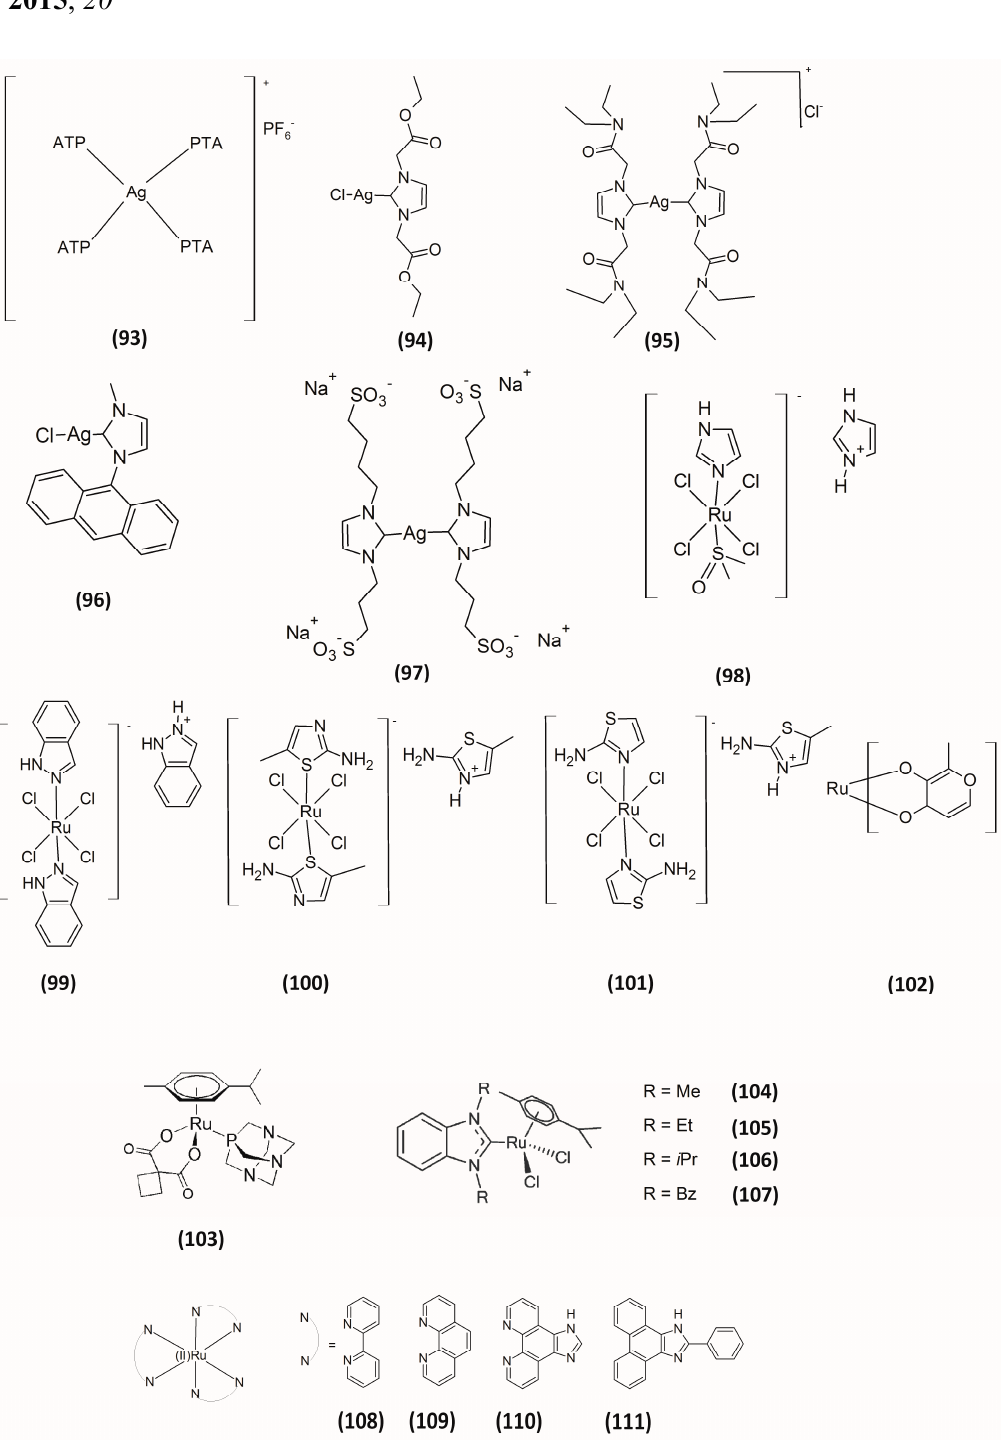
Figure 6. Structures of silver-based and ruthenium-based